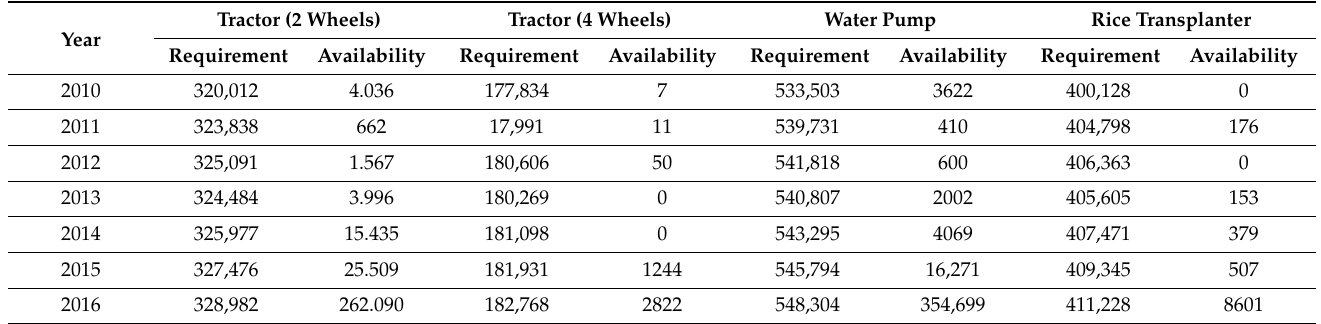
Table 1. The requirement and availability of agricultural machine tools in Indonesia